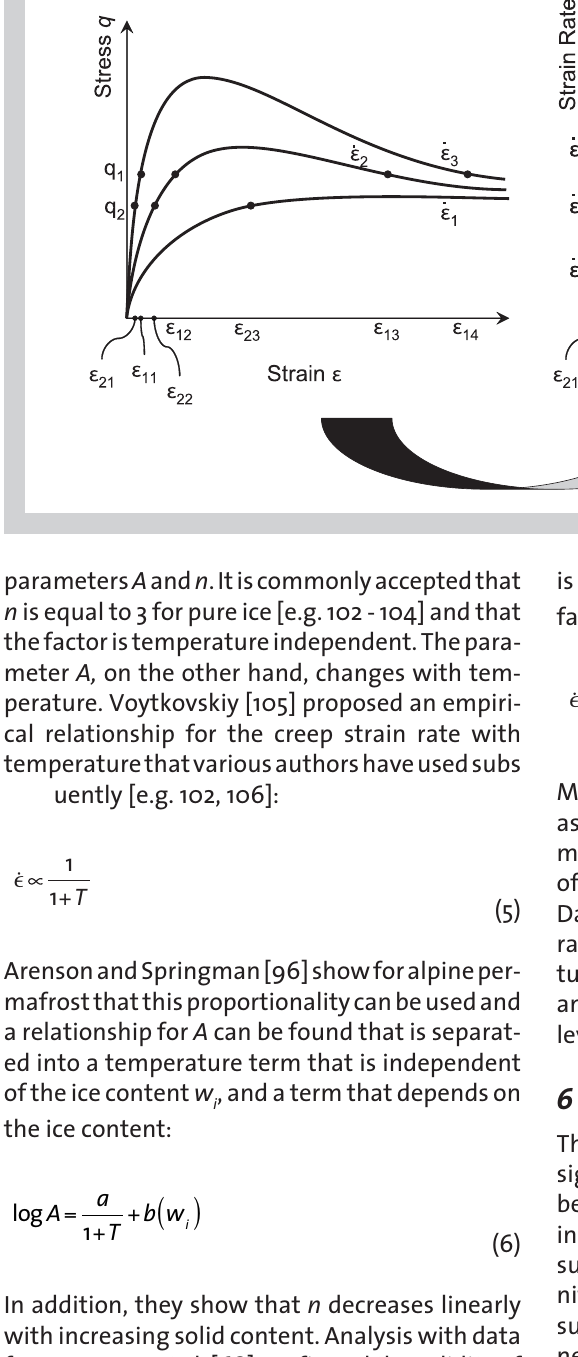
Figure 10: Estimation of creep curves based on a series of con- stant strain rate (CSR) tests (after